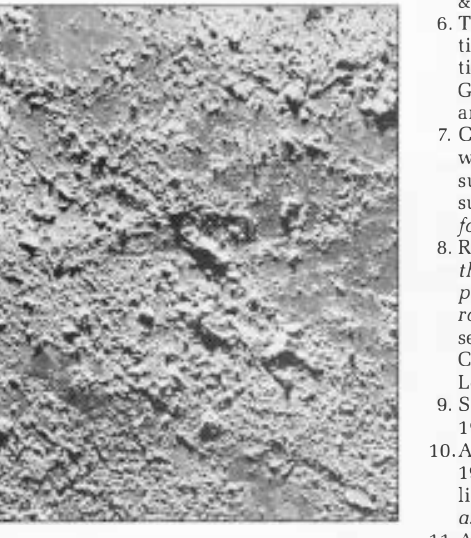
Figure 5 Detail of salt damage to part of a thirteenth-century wall painting on the south wall of the sacristy of Cleeve